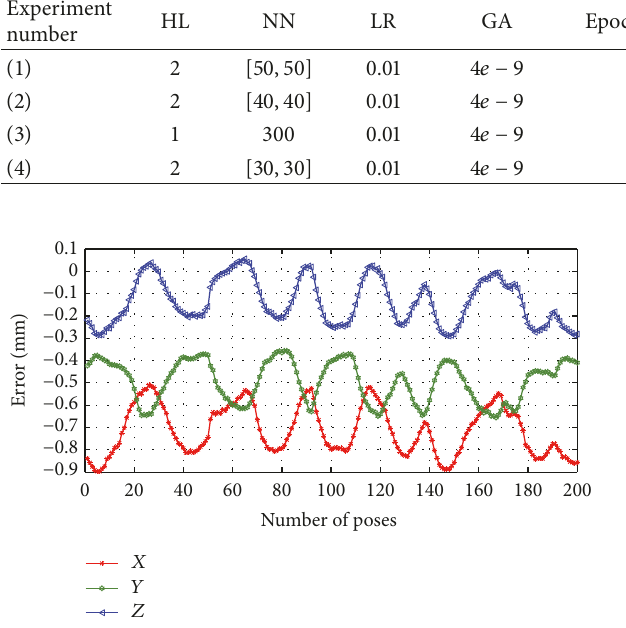
Figure 6: The errors of the AACMM before compensation.